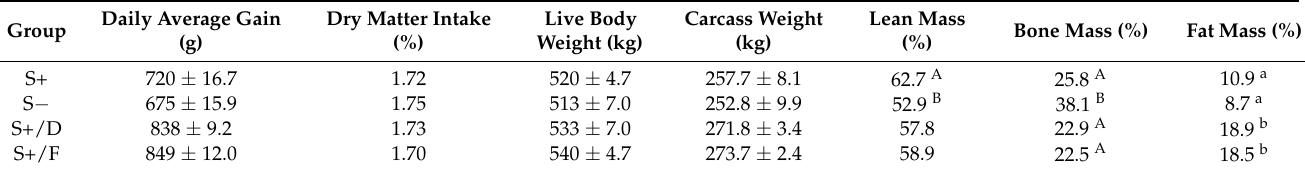
Table 3. Effects of availability of space and different feeding regimen on animal growth, daily average gain, dry matter intake, live body weight at slaughterhouse, and carcass weight and yield of buffalo meat in animal bred at 10 m 2 (S − ), at 15 m 2 (S+), and fed total mixed ratio (S+/D) or green forage (S+/F). Values are expressed in percentages or as the mean ± ES. Group